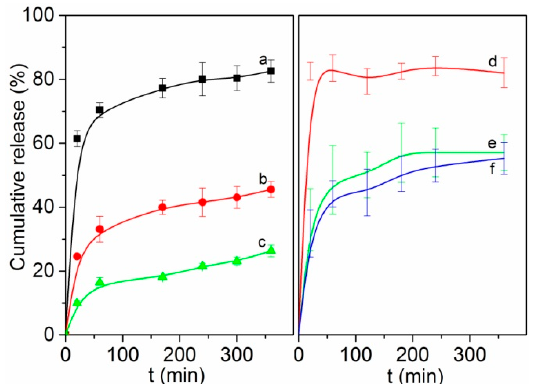
Figure 7. Cumulative release of hydrocortisone ( a – c ); and lysine ( d – f ) in simulated gastric fluids from the microparticles obtained with an ethanol/water mixed solvent of 4:1 volume ratio at a drying temperature of 95 ( a ); 100 ( b , d ); 155 ( c , e ); and 205 °C ( f ), respectively.